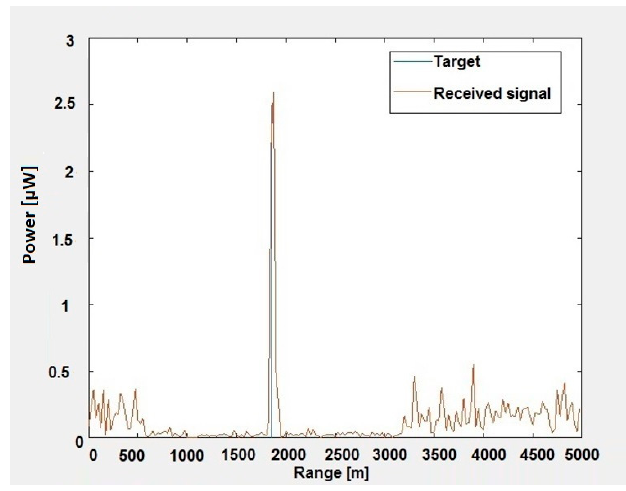
Figure 6. Values of signals received by the MIMO radar array as a function of range after STAP processing.